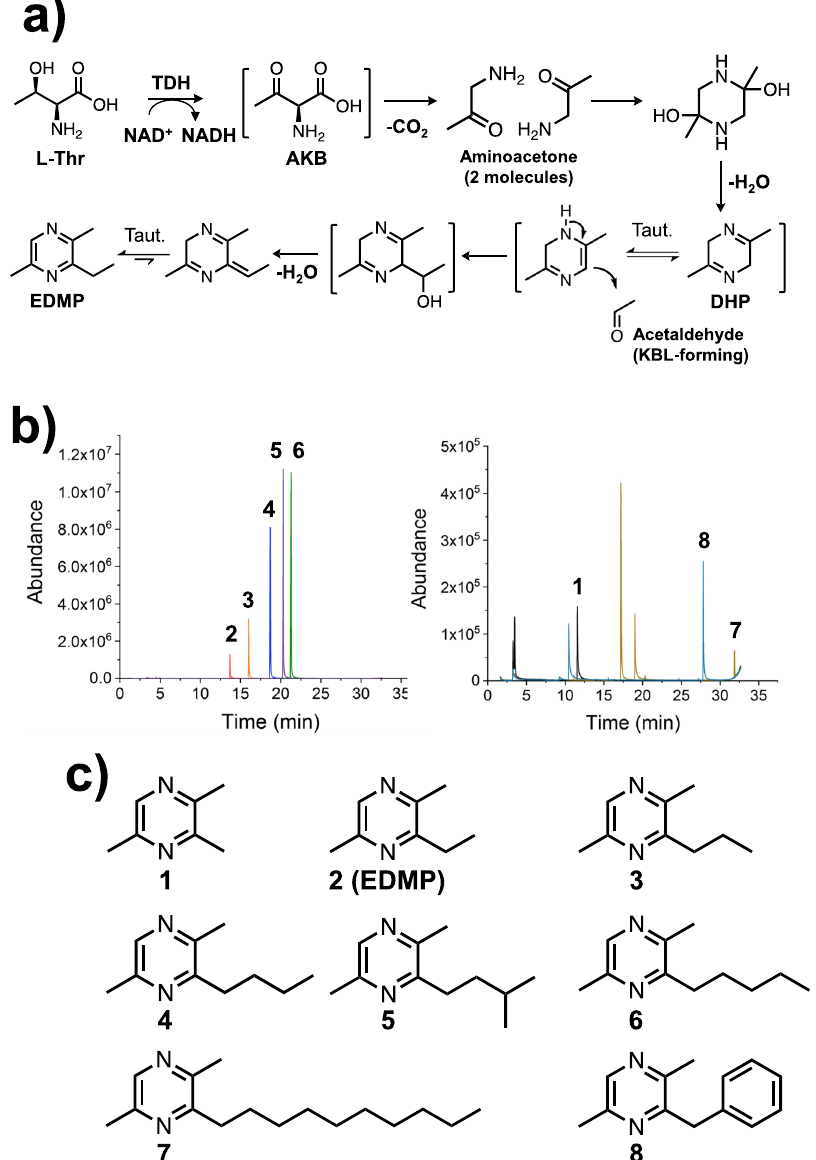
Fig. 7 Chemoenzymatic synthesis of alkylpyrazines under conditions containing aminoacetone, which is provided by CnTDH and aldehydes. a Reaction scheme of the chemoenzymatic production of EDMP. Taut. indicates tautomerization. b GC-MS chromatograms of synthesized alkylpyrazines. The peaks can be detected in the reaction conditions containing the following aldehydes: formaldehyde (black), acetaldehyde (red), propionaldehyde (orange), butyraldehyde (blue), isovaleraldehyde (purple), valeraldehyde (green), decylaldehyde (yellow), and benzaldehyde (cyan). c A list of pyrazines produced from chemoenzymatic reactions is shown as 1 –